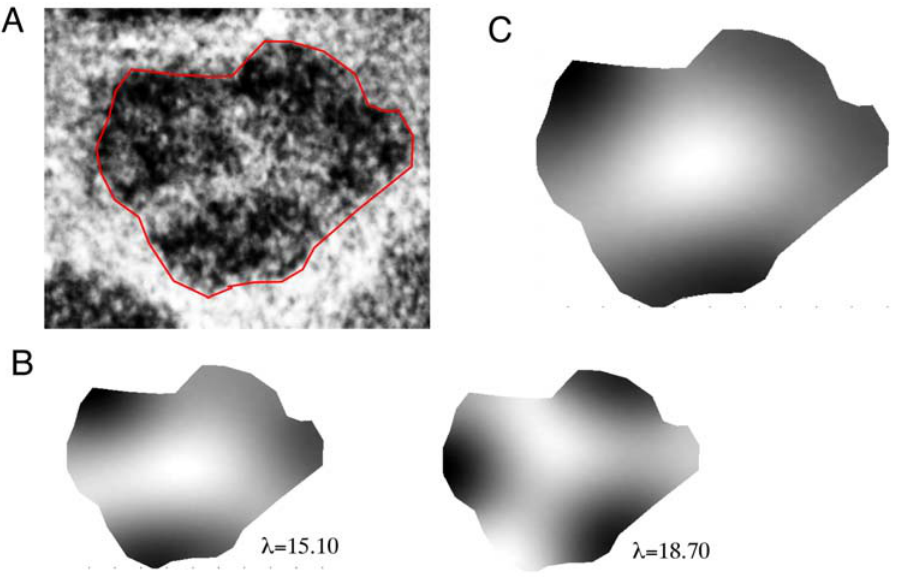
Figure 6. Irregular barrel with a mercedes pattern. (A) Image of the actual barrel showing the piecewise linear approximation of the boundary (red). (B) Two eigenfunctions with nearby eigenvalues. (C) Superposition of two patterns in (B).